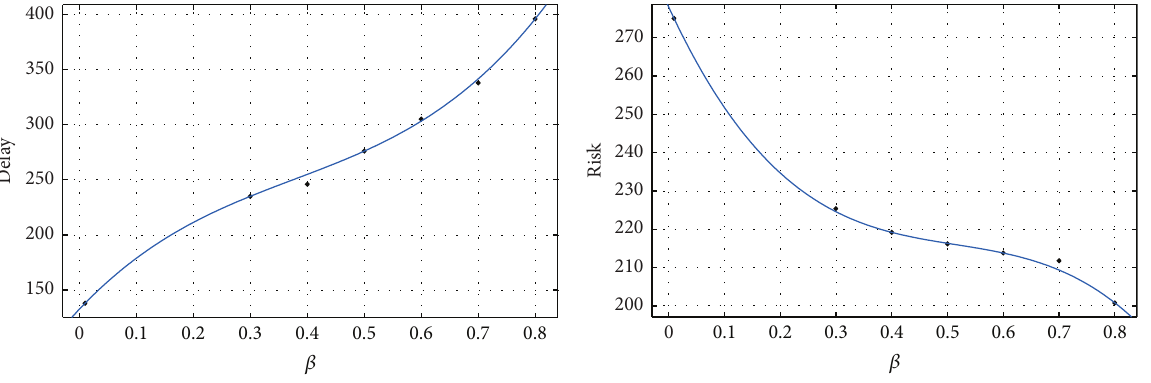
Figure 3: Demonstration of delay cost and risk with 𝛽 .